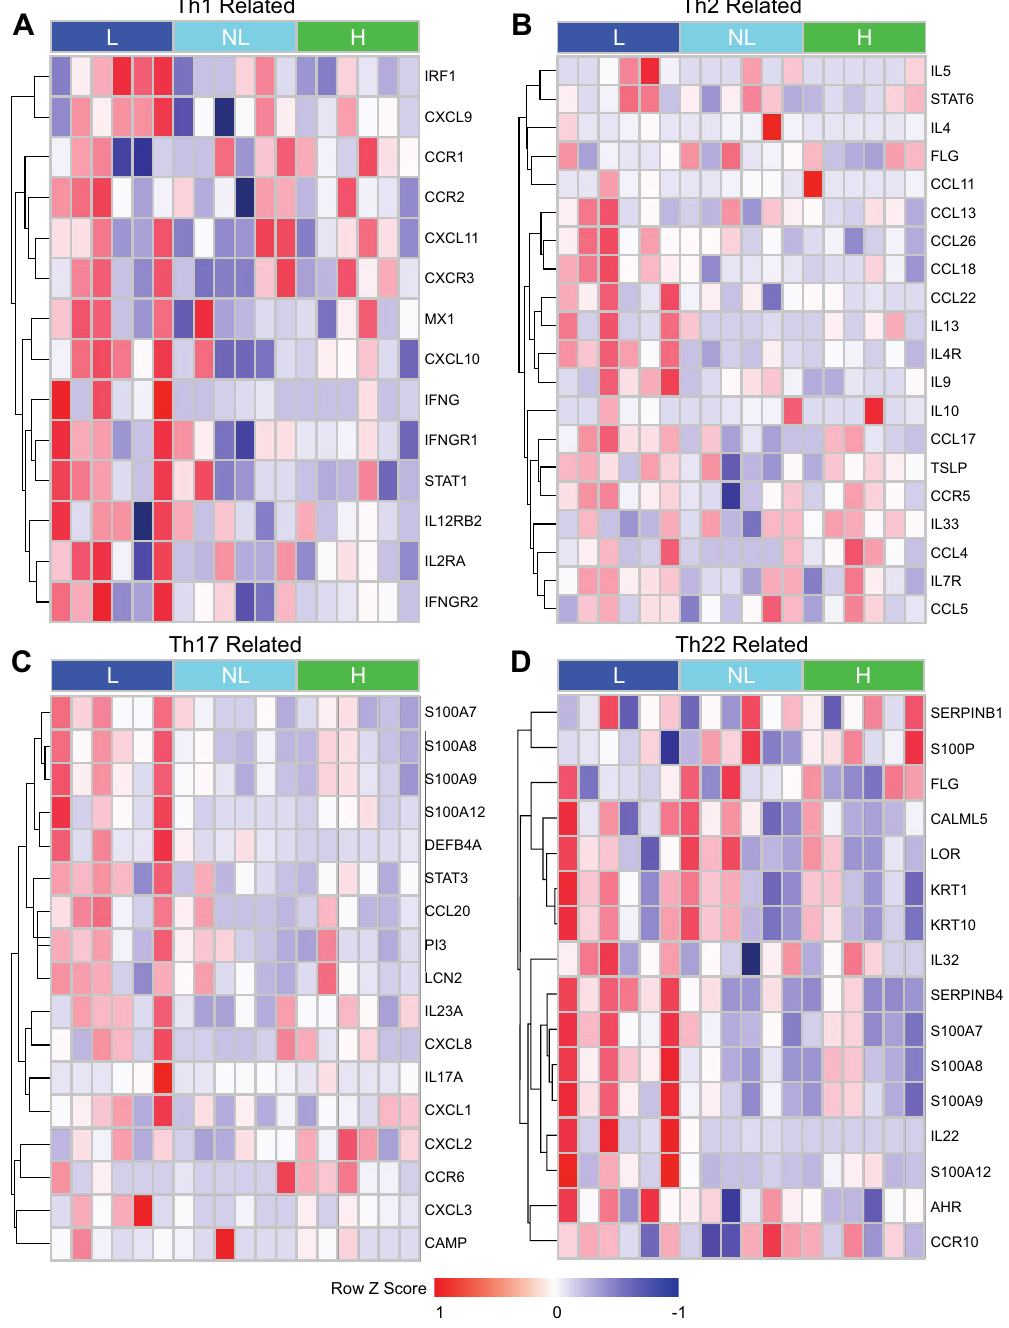
Figure 4. Heatmap of Th1-, Th2-, Th17-, Th22- related genes by mRNA-seq in AD lesional (L), AD non- lesional (NL), and matched healthy control (H) skin samples. Upregulation and downregulation denoted by red and blue, respectively. Heatmaps were created with R version 4.0.2 (R Statistical Software) using the pheatmap package (https:// cran.r- proje ct. org/ web/ packa ges/ pheat map/ index.